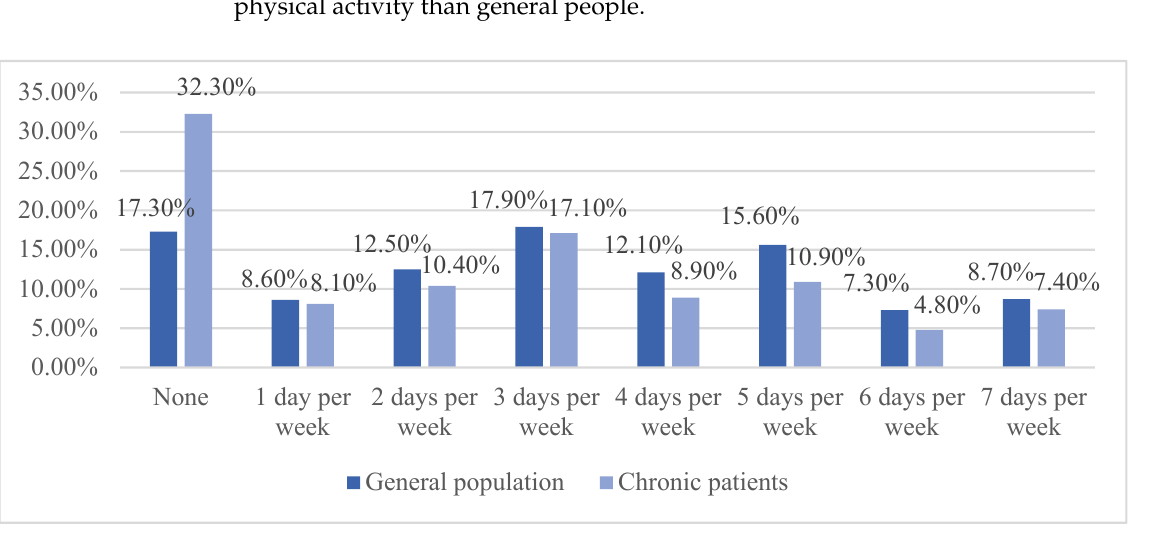
Figure 1. Differences in at least moderate exercise between the general population and chronic patients. The horizontal axis represents different exercise levels, and the vertical axis represents the proportion of people with each level of exercise.